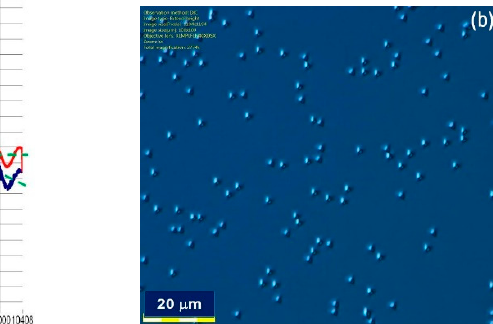
Figure 2. ( a ) ω /2 θ scan of QCL sample; ( b ) reciprocal space map of X-ray intensity around 004 Bragg reflection for In 0.53 Ga 0.47 As/In 0.52 Al 0.48 As/InP QCL. Diffuse X-ray scattering is seen as isointensity